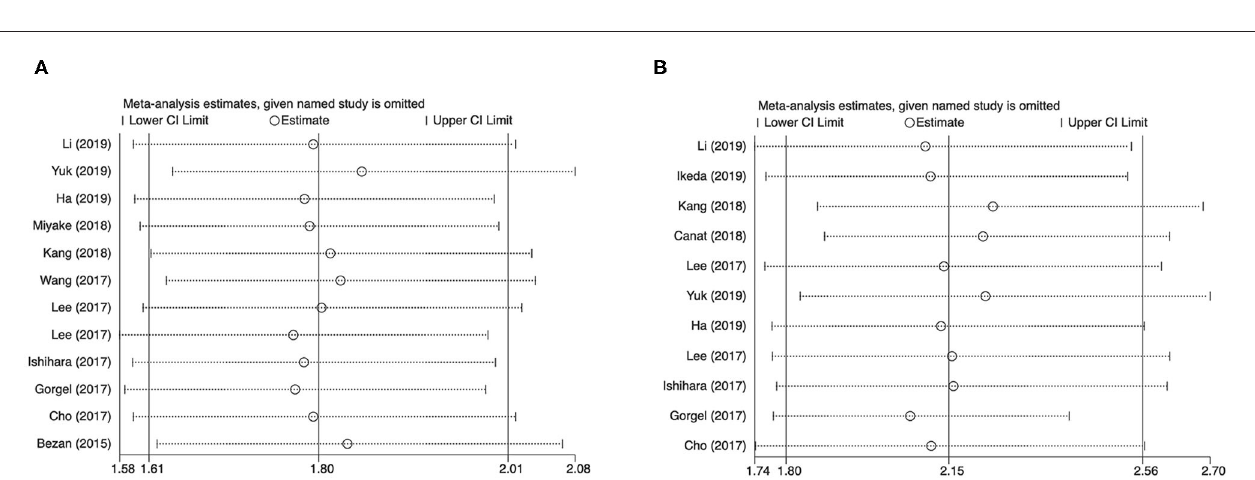
also showed low possibility of publication bias for OS ( P =